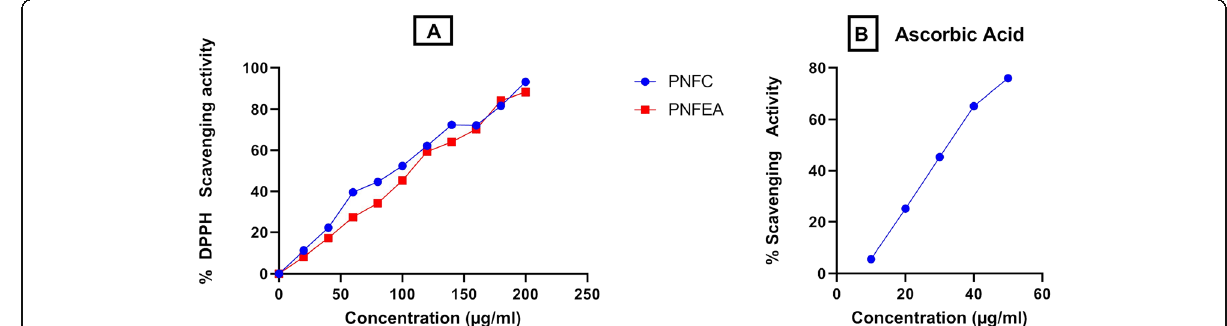
Fig. 4 DPPH radicals scavenging activity of a PNFC and PNFE ( b ) ascorbic